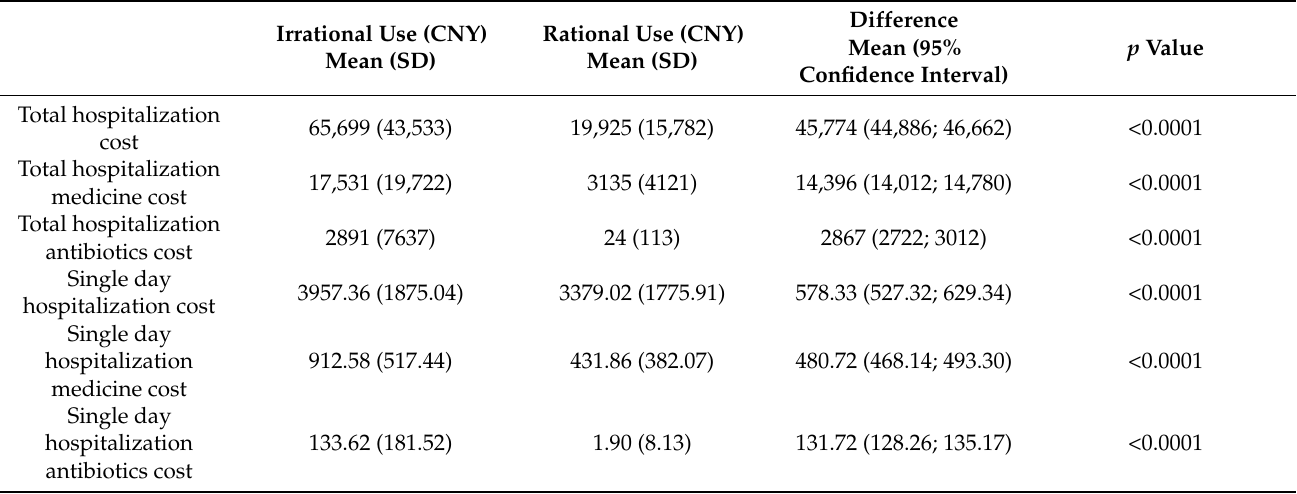
Table 6. Results of t -tests for cost comparisons between rational and irrational use of prophylac- tic